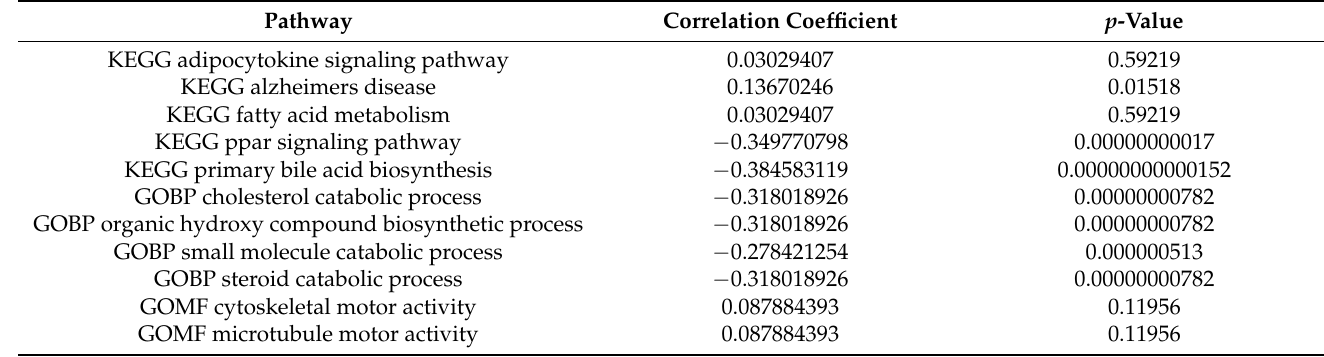
Table 5. Correlations between the Functional Enrichment Results and the Risk Score.